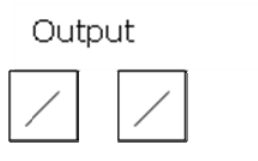
Figure 3. Network initialization of a RBFCCN. This network has three input neurons and two output